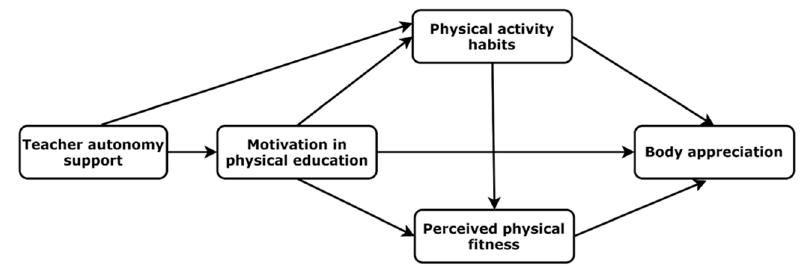
Figure 1. Hypothetical model of the associations between study